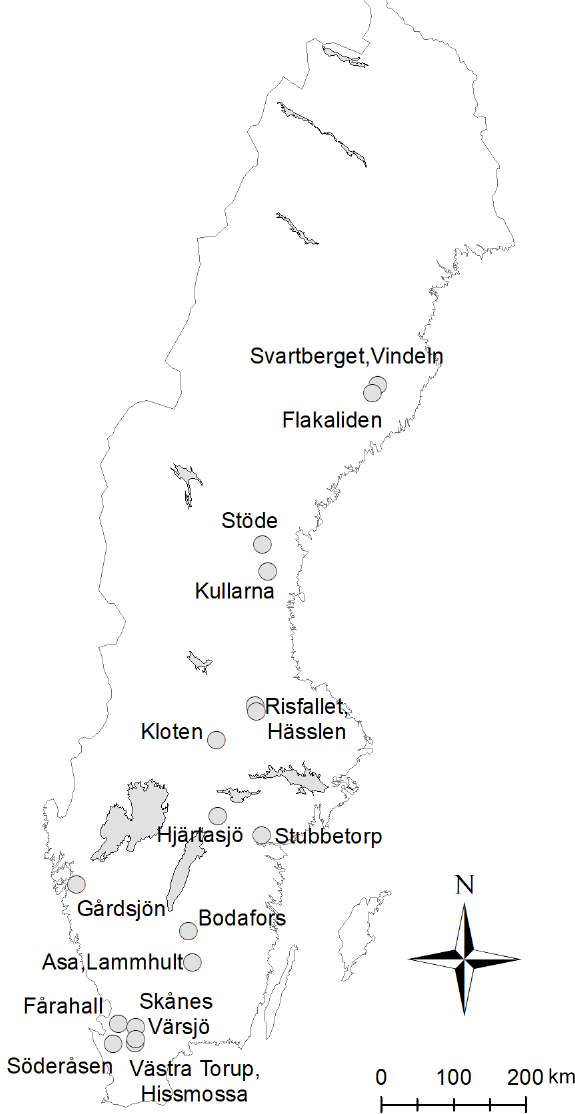
Figure 2. Well-investigated sites where weathering rates have been calculated for the same soil depth with at least two different ap- proaches. See also Table